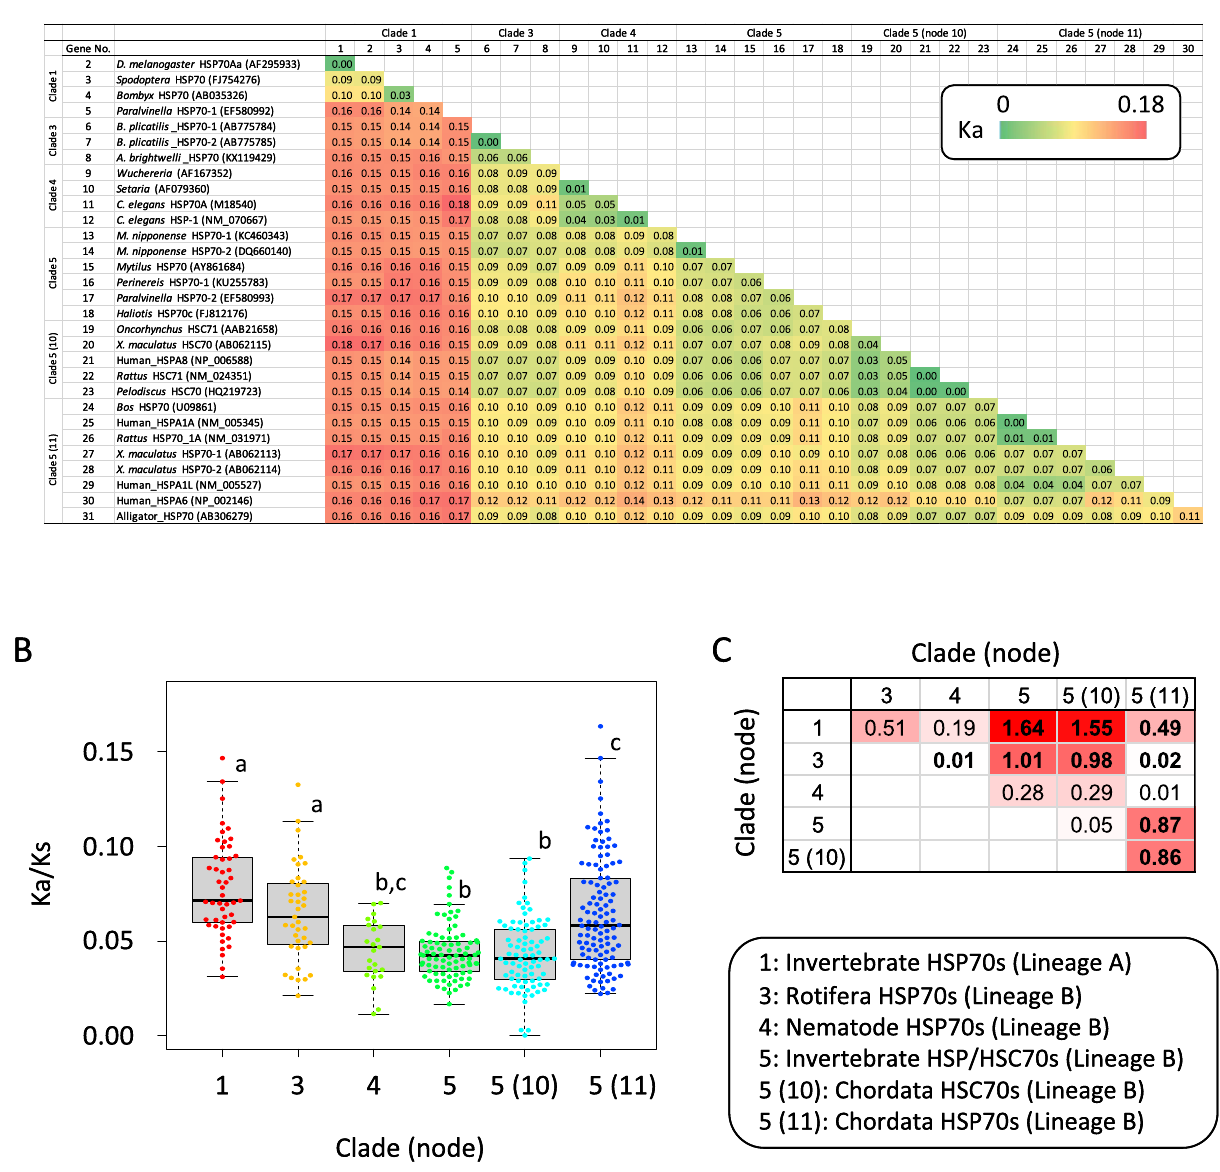
Figure 4. Selection pressure on cytosolic HSP70 family member genes. ( A ) Nonsynonymous substitution rates (Ka values) between 34 HSP70 family member genes. Gene number 1 is the fruit fly HSP70 Bb (AF295957) gene. The substitution rate of fruit fly HSP70 Aa and Bb gene was 00395526, which is shown as 0.00 in the figure. Accession numbers for other genes are indicated in the figure. Clades and nodes correspond to those in Fig. 2. ( B ) Bee swarm boxplots of Ka/Ks values for each clade. Only Ka/Ks values calculated from inter-cluster pairs were averaged. Statistical differences were calculated by Kruskal–Wallis test (chi-squared = 88.704, df = 5, P < 2.2e−16) followed by the non-parametric post-hoc tests (pairwise Wilcox test with P value adjustment by the Holm method). Clades sharing same letters are not significantly different at the 5% level of significance. One outlier in clade 3 (0.53) is not included in the plot (see supplementary material 1) although this value was used for all statistical analyses. ( C ) Effect sizes (Cohen’s d) for all comparisons. Combinations where significant differences were found in the pairwise Wilcox test are shown in